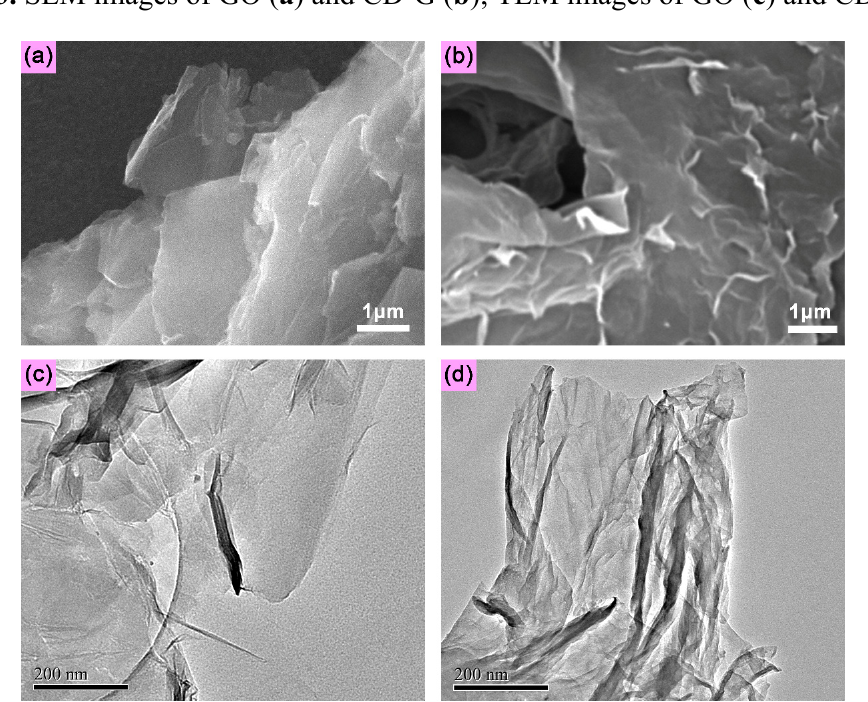
Figure 3. SEM images of GO ( a ) and CD-G ( b ); TEM images of GO ( c ) and CD-G ( d